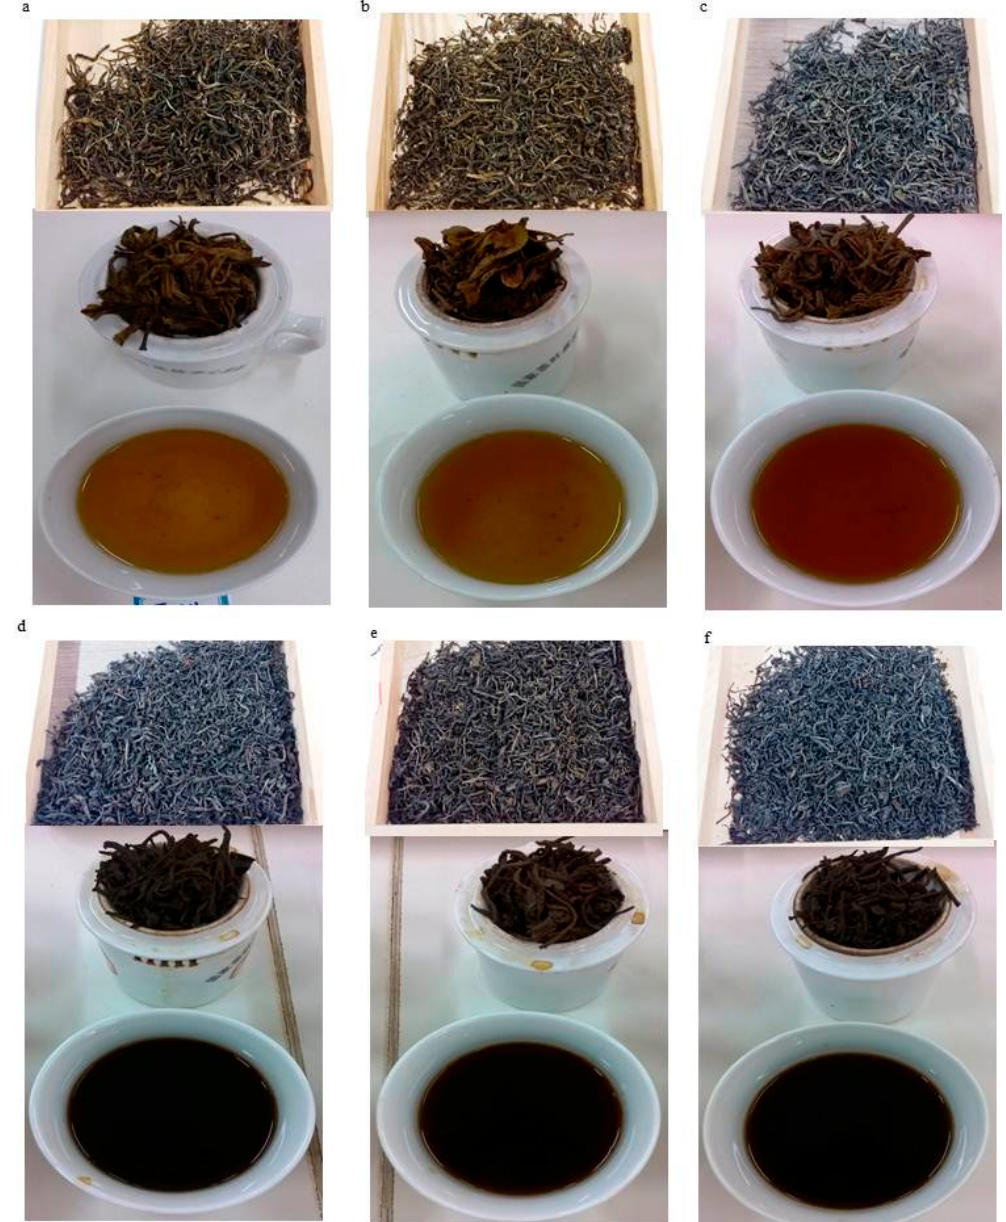
Figure 1. The representative sensory evaluation of tea leaves collected on day 0 ( a ); 7 ( b ); 14 ( c ); 21 ( d